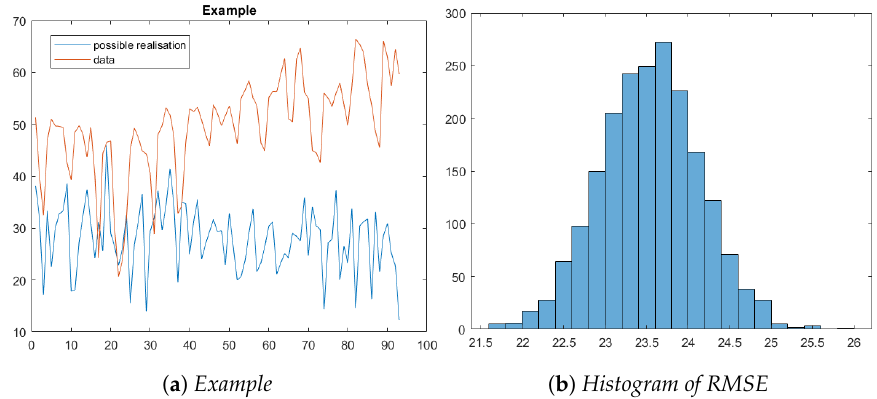
Figure 10. Use of summer of 2016 and 2017 for possible data of summer in